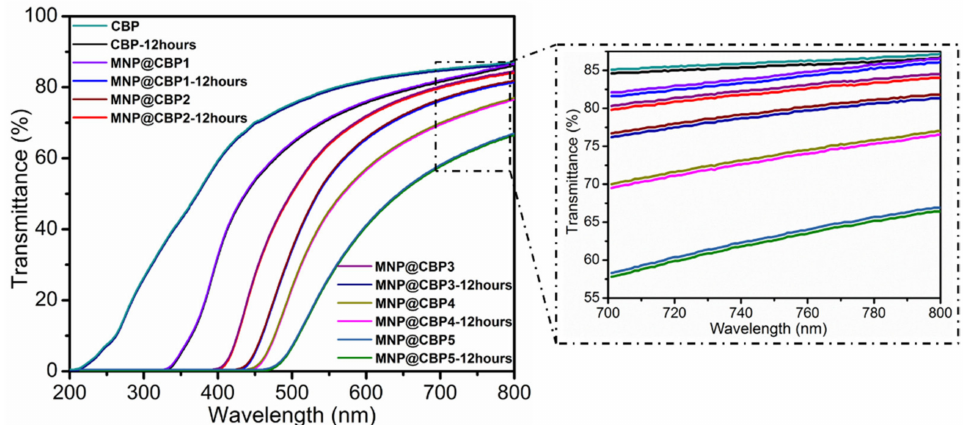
Figure 8. Photostability of CBP and MNP@CBPs.